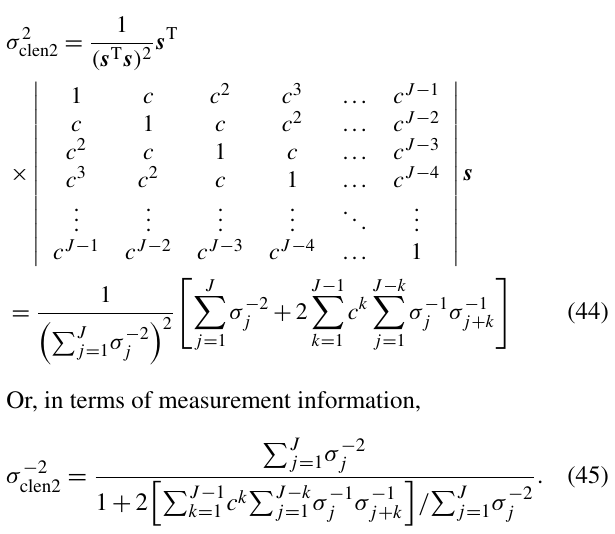
fied error cases used above as a function of (cid:49)x : for our 10 s averages, we look at (cid:49)x = 67 . 5 km, finding that the total in- formation multiple is about 200 for the uncorrelated error case (green line), which is close to the J = 198 value, as it should be. By comparing the information values for the un- correlated error case (green line) to the values from the expo- nential correlation cases (red and magenta lines), we can see the impact of the correlations in reducing the total informa- tion content in the lower (cid:49)x range. Curves for three different correlation lengths (10, 20, and 40 km) are given; curves for measurement errors for the two different formulations of the mean (from Eqs. 22 and 45, the red and magenta curves in Fig. 2) are both plotted but fall on top of each other in this (cid:49)x range. By comparing the information assuming no cor- relations (green) versus exponential correlations (magenta), one can derive a single scalar multiple (greater than 1) of the uncertainties on the 10 s averages that will permit the 10